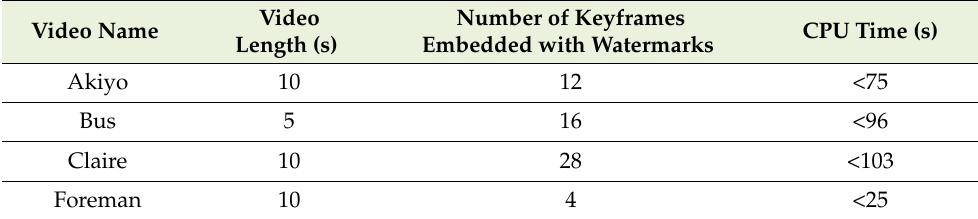
Table 1. Watermark embedding extraction time of four classical